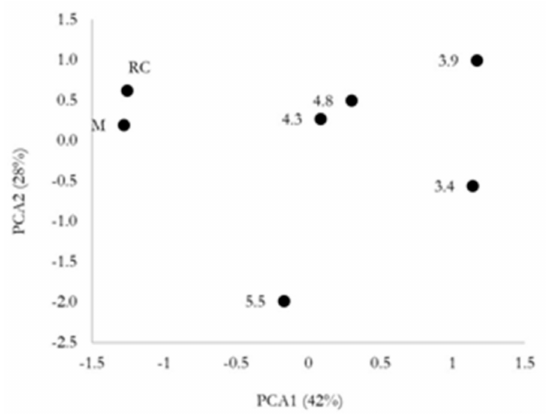
Figure 4. The PCA1-PCA2 scatterplot from the principal component analysis conducted on farmers’ evaluations of potential yield, fruit appearance, and fruit marketability.